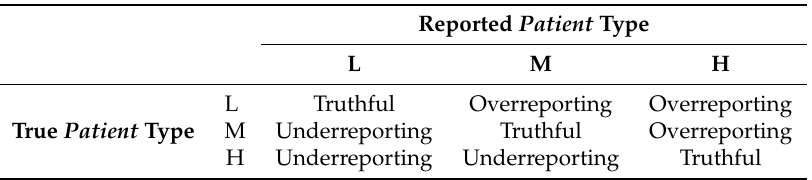
Table 3. Reporting options of the Physician